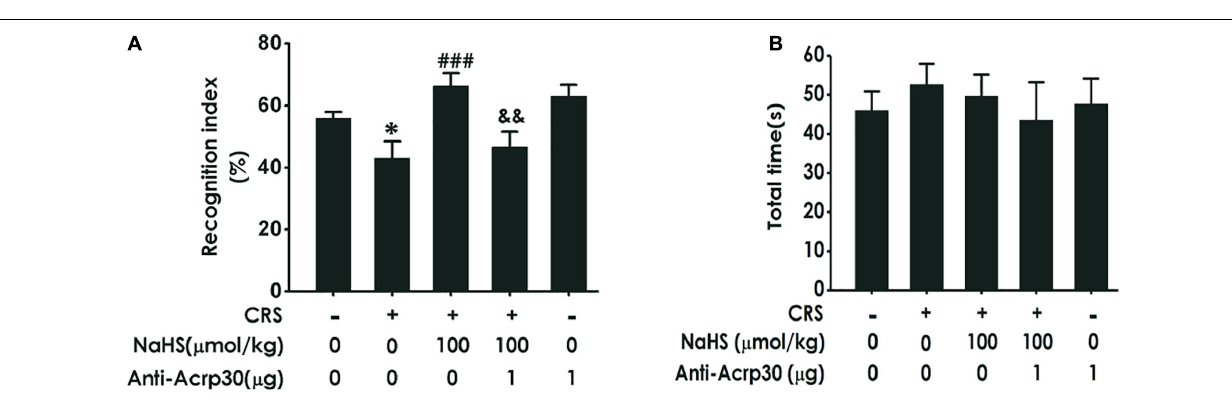
FIGURE 3 | Effects of Anti-Acrp30 on NaHS-improved cognitive impairment in CRS-exposed rats in novel object recognition test. Rats were co-treated with NaHS (100 µ mol/kg/day, i.p.) and CRS (6 h/day) for 3 weeks, and then co-administrated with Anti-Acrp30 (1 µ g/day, i.c.v.) for further 1 week. The cognitive function was detected by the novel object recognition test and the discrimination index (A) and the total object exploration time (B) of rats were respectively recorded. All values are expressed as mean ± SEM ( n = 8–10/group). * P < 0.05, vs. control group; ### P < 0.001, vs. CRS-exposed alone group; && P < 0.01, vs. co-treatment with NaHS and CRS